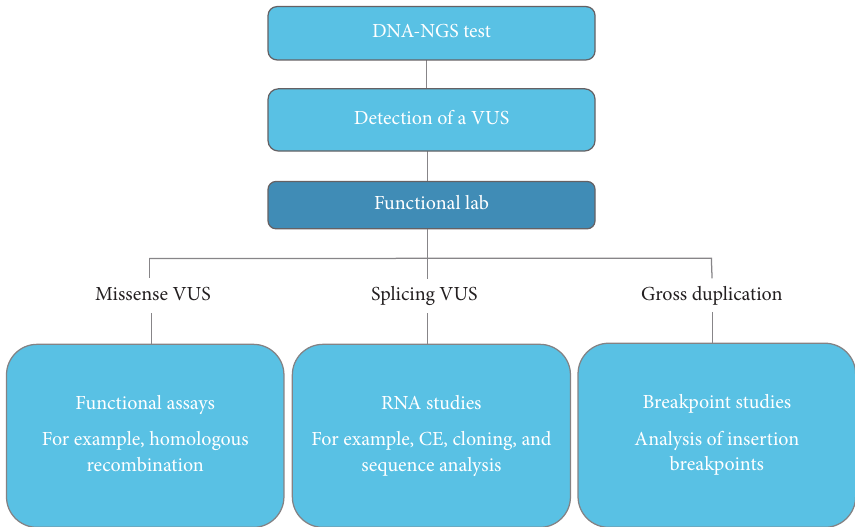
Figure 2: Workflow of a functional lab for the evaluation of VUS.